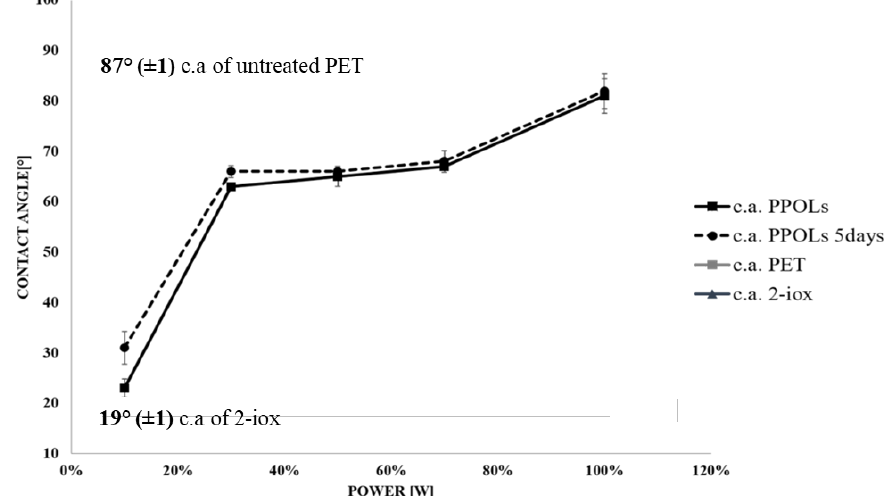
Figure 2. c.a. in the pulsed regime at different powers; the values were measured on PET sheets. The values of the contact angle are the average of 5 values collected for each sample.